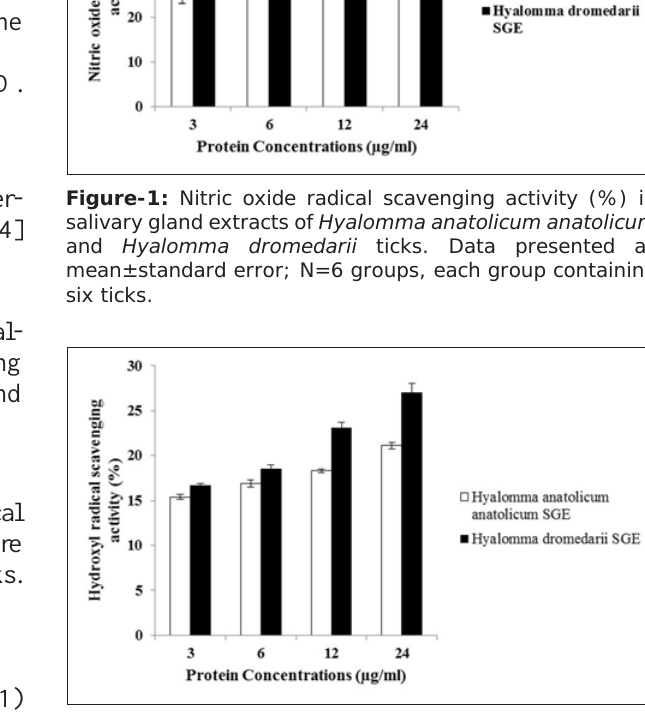
Figure-2: Hydroxyl radical scavenging activity (%) in salivary gland extracts of Hyalomma anatolicum anatolicum and Hyalomma dromedarii ticks. Data presented as mean±standard error; N=6 Groups, each group containing six